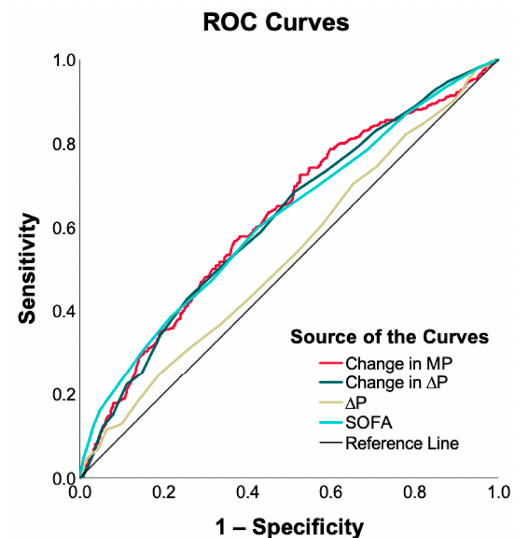
Figure 3. Receiver operating characteristic (ROC) curves of change in mechanical power (MP), change in driving pressure ( ∆ P), ∆ P, and Sequential Organ Failure Assessment (SOFA) scores for 30-day mortality in patients with acute respiratory distress syndrome (ARDS). The areas under the ROC curve (AUROCs) were calculated. The AUROCs for change in MP, change in ∆ P, ∆ P, and SOFA scores were 0.620 (95% confidence interval (CI), 0.583–0.657; p < 0.001), 0.616 (95% CI, 0.579–0.653; p < 0.001), 0.532 (95% CI, 0.494–0.570; p = 0.096), and 0.617 (95% CI, 0.580–0.654; p < 0.001), respectively. To evaluate the changes in ∆ P and MP, patients were divided into two groups ac- cording to serial decrement (changes in ∆ P and MP < 0) and increment (changes in ∆ P and MP ≥ 0). Thirty-day survival differed significantly between these groups (log-rank test, p < 0.001) (Figure 4). The 30-day survival rate in the serial decrement group was significantly higher than that in the serial increment group, regardless of whether ∆ P or MP was used.